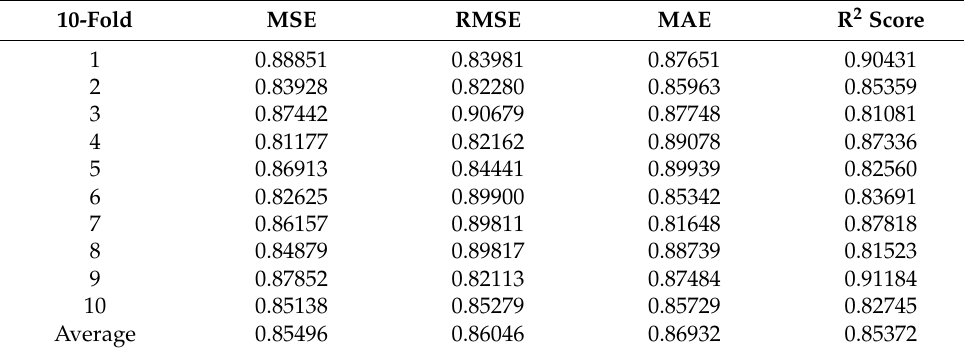
Table 12. Results for